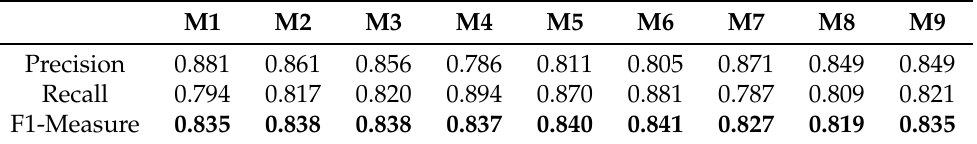
Table 5. The results of model classification under different training conditions. F1-Measure that is most suitable for overall accuracy evaluation has been